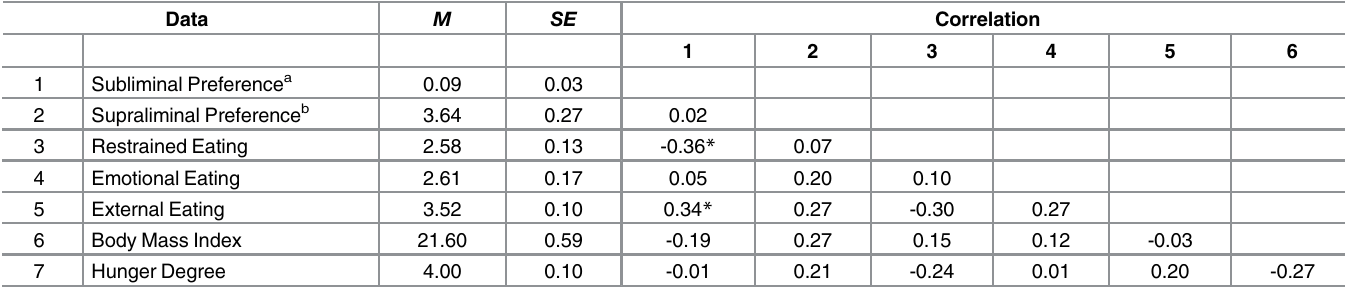
Table 2. Mean (with SE ) data and their